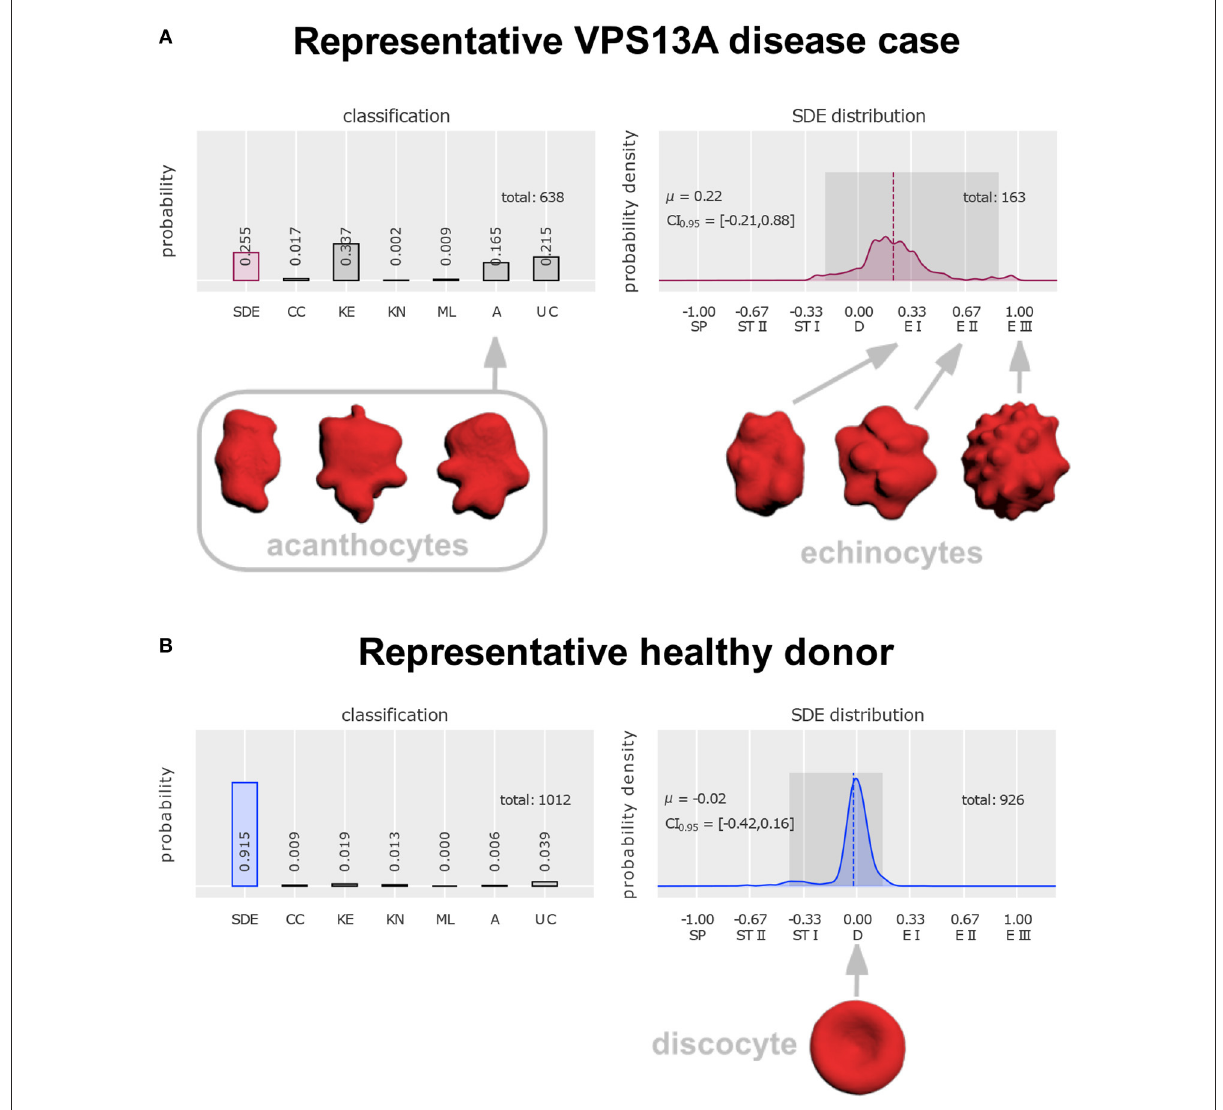
FIGURE1 Distinction of acanthocytes from echinocytes based on 3D confocal images and classification with artificial neural networks [figure modified from Rabe et al. (2021)]. To arrive at these classifications, a drop of blood was dropped directly (i.e., without anticoagulant exposure) from the blood-drawing needle tip into glutaraldehyde for fixation (Abay et al., 2019), followed by staining with Cell Mask deep red and confocal microscopic imaging (Quint et al., 2017). Artificial intelligence-based classification allows unbiased automated analysis, including a “stomatocyte-discocyte-echinocyte” (SDE) classification on a continuous scale (instead of in discrete classes). For design and validation of the artificial neural network see (Simionato et al., 2021). (A) Classification of erythrocytes from a patient with genetically proven VPS13A disease (chorea-acanthocytosis). The first column on the left reflects the fraction of cells that follow the SDE sequence that erythrocytes show under appropriate environmental conditions. Their distribution is plotted in the right diagram. Its zero value denotes perfect discocytes (D) and positive or negative deviations correspond to echinocytosis (E I–E III) and spherocytosis (SP)/stomatocytosis (ST I–ST II), respectively. Examples of echinocyte types I to III are depicted on the right. The left diagram represents abnormal cell shapes, namely cell clusters (CC), keratocytes (KE), knizocytes (KN), multilobate cells (ML), acanthocytes (A), and unclassifiable cells (UC). Examples of acanthocytes are depicted on the left. (B) Erythrocyte classification of a representative healthy donor and depiction of a perfect discocyte. For patient (A) and control a total of 638 and 1,012 erythrocytes, respectively, were analyzed. In the control a majority of 91.5% conformed with the SDE range (only 25.5% in the patient). There were 16.5% acanthocytes in the patient sample. Apart from detection of a few acanthocytes (0.6%) also in the control, the patient displayed various other irregularly shaped cells (keratocytes, knizocytes, multilobate cells, and unclassifiable cells) in greater abundance (59.3%) than the control (7%). Further, the probability density of the patient’s SDE distribution and that of the control differ considerably—due to the presence of echinocytes in the patient that are almost completely absent in the